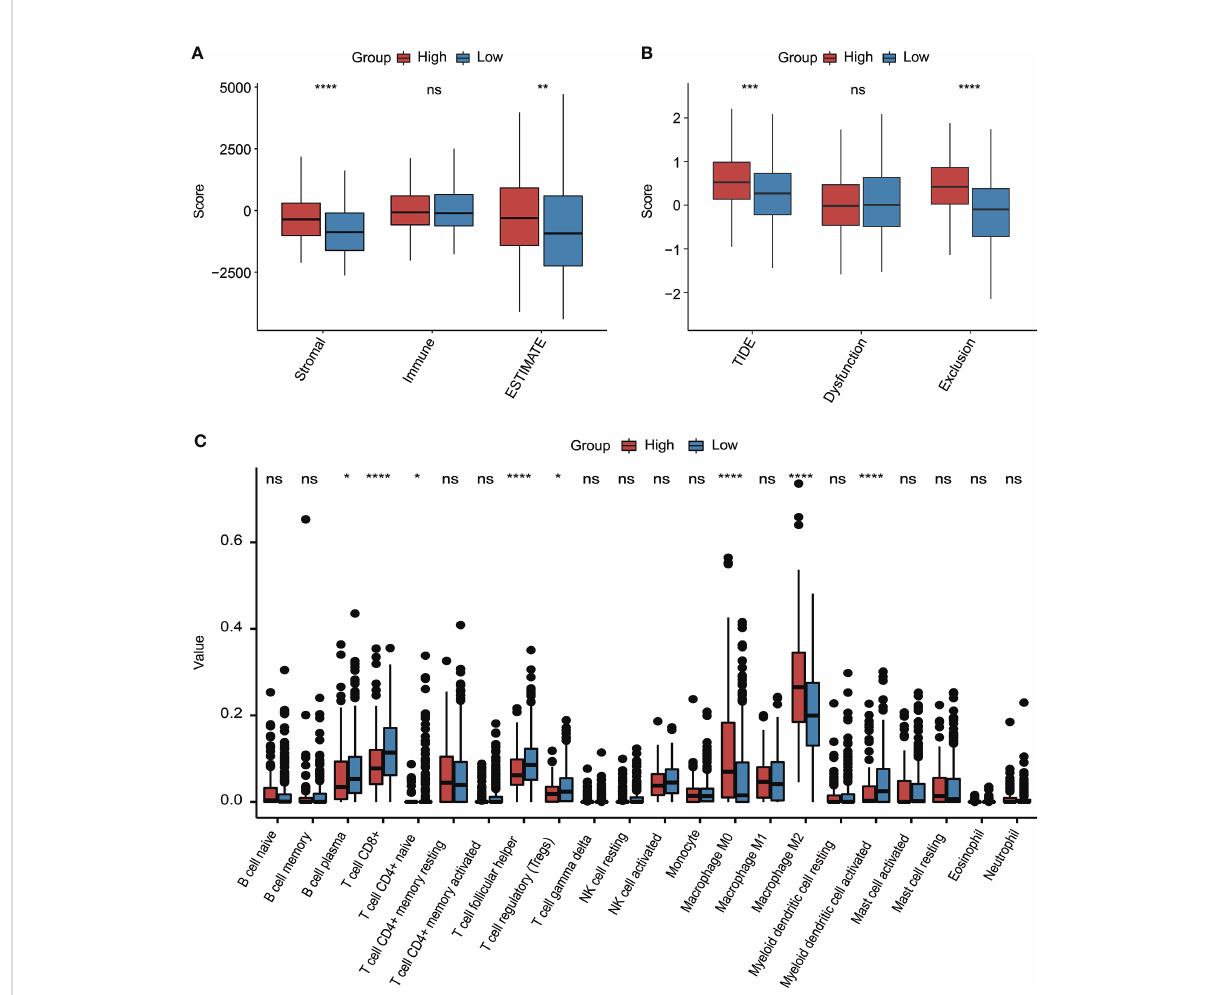
FIGURE 8 The evaluation of tumor environment between high-risk and low-risk groups. (A) Comparison of stromal, immune, and ESTIMATE scores between high-risk and low-risk groups. (B) Comparison of T-cell dysfunction, exclusion, and TIDE scores between high-risk and low-risk groups. (C) The evaluation of 22 tumor-in fi ltrated lymphocytes between high-risk and low-risk groups. *p < 0.05, **p < 0.01, ***p < 0.001, ****p < 0.0001, ns represented “ not signi fi cant ”